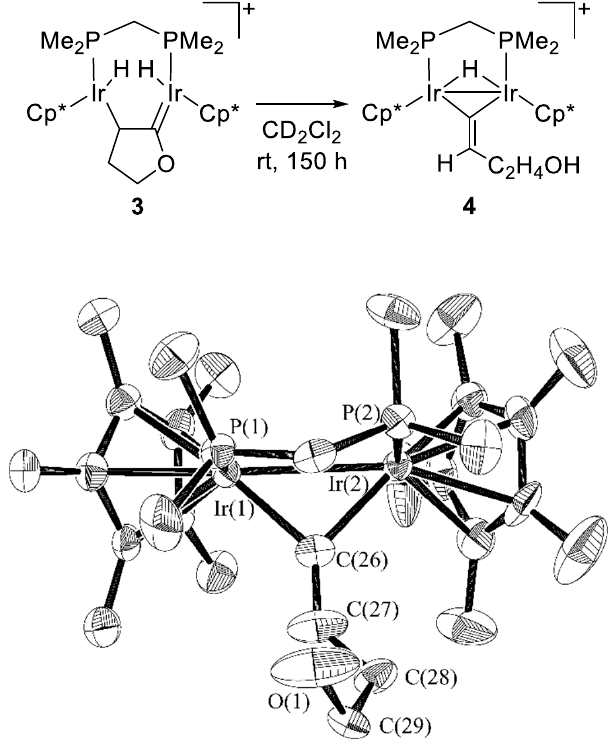
Figure 3. ORTEP drawing of the cationic part of 4 . Hydrogen atoms are omitted for clarity.